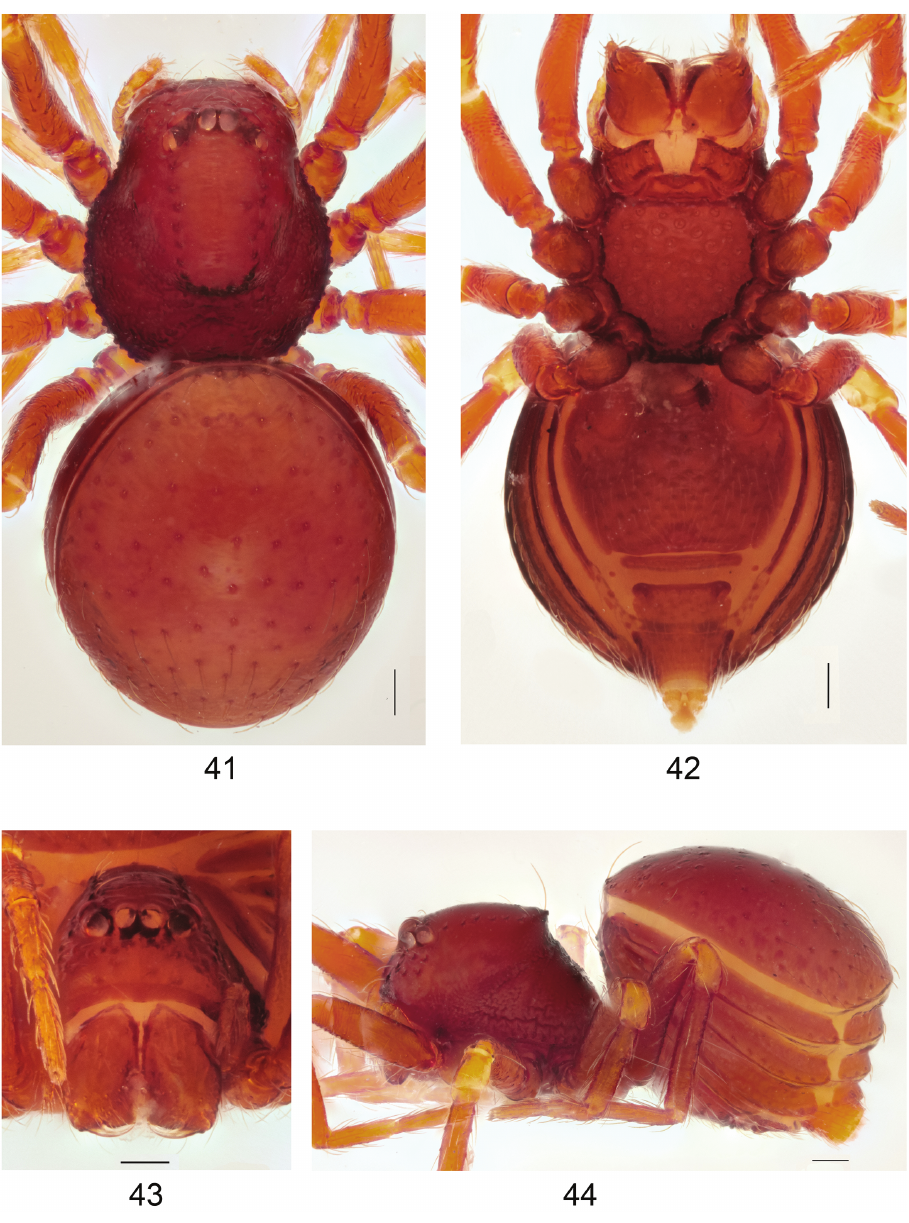
Figures 41–44. Brignoliella patmae sp. n., female. 41 Habitus, dorsal view 42 Habitus, ventral view. 43 Carapace, frontal view. 44 Habitus, lateral view. Scale bar: 1.0 mm. gose, steeply sloping (Figs 34, 37); clypeus brown, punctated; clypeal horn fairly long, distally bifid (Figs 34, 37). Sternum : Brown; as long as wide; deeply punctated (Fig. 35). Chelicerae : Brown, punctated; cheliceral boss a pointed projection; cheliceral